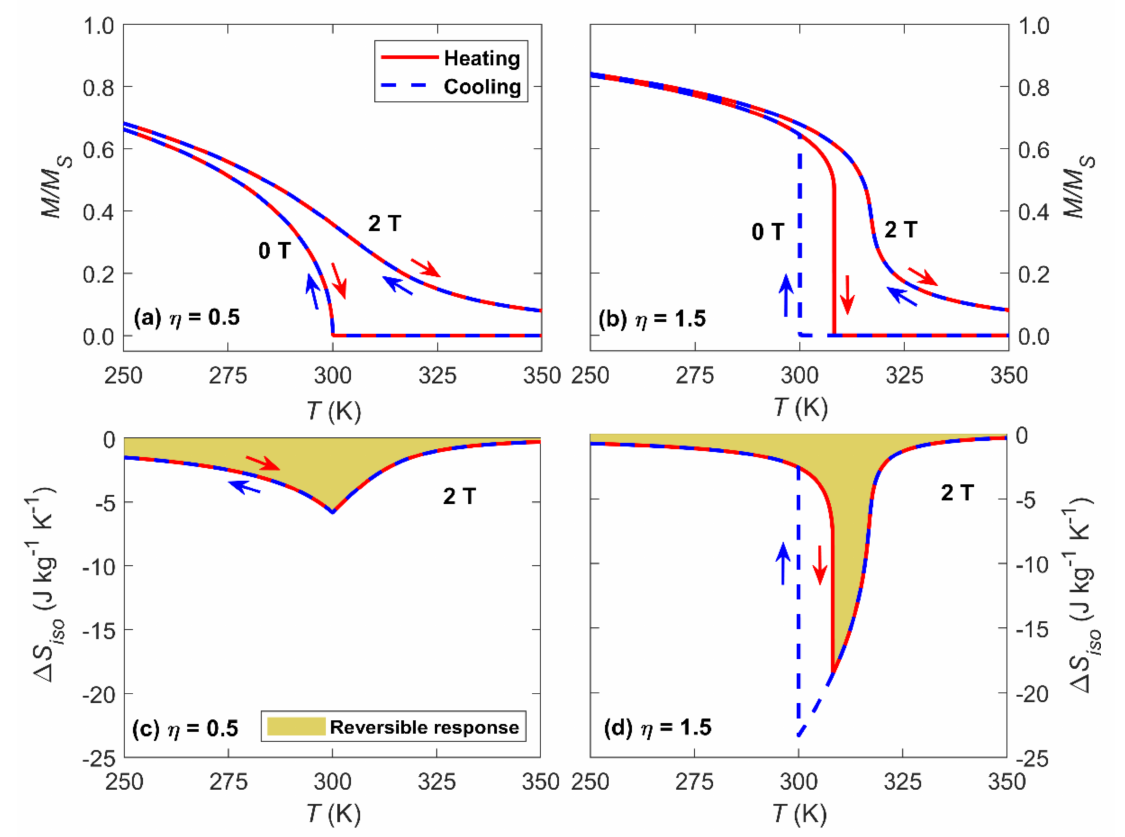
Figure 1. Temperature dependence of M for an atomic magnetic moment of 7 µ B for 0 and 2 T for ( a ) η = 0.5 (SOPT) and ( b ) η = 1.5 (FOPT). Corresponding ∆ S iso (from previous magnetization data) for ( c ) η = 0.5 and ( d ) η =